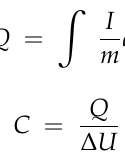
Figure 6. The galvanostatic charge/discharge (GCD) curves of Co 3 O 4 ( 1 ) and Re-Co 3 O 4 ( 2 ) electrodes at current density of 0.24 A g −1 and 0.38 A g −1 , respectively.